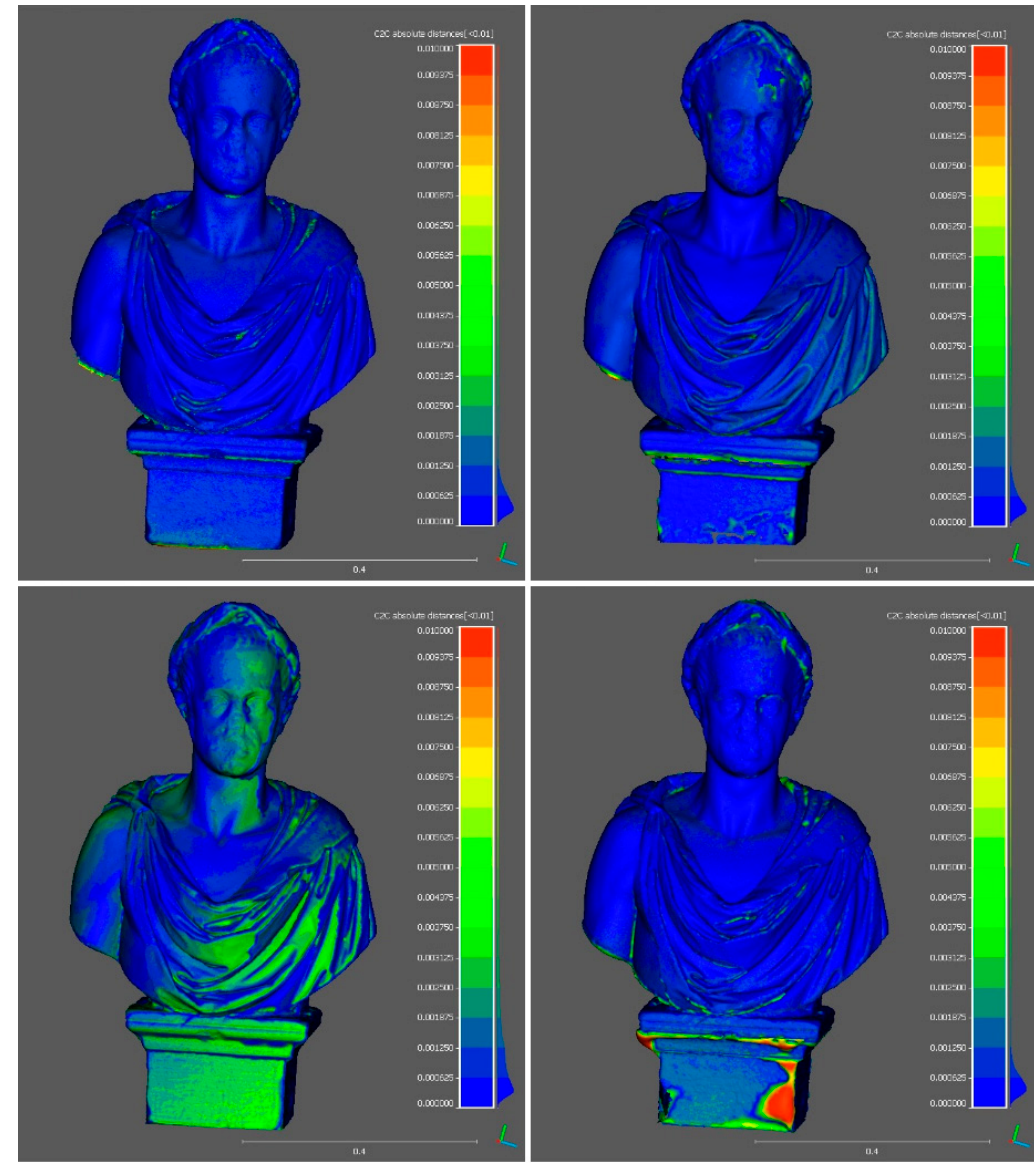
Figure 16. Scalar field mapping of Hausdorff distances between dataset 6 photogrammetric results and scanning results. Deviation between the F6 SR mesh and the AMP mesh ( upper left ), deviation between the F6 SR mesh and the FZA mesh ( upper right ), deviation between the F6 SR mesh and the ARP mesh ( lower left ), deviation between the F6 SR and the VCM mesh ( lower right ); maximum visualized distance: 1 cm.